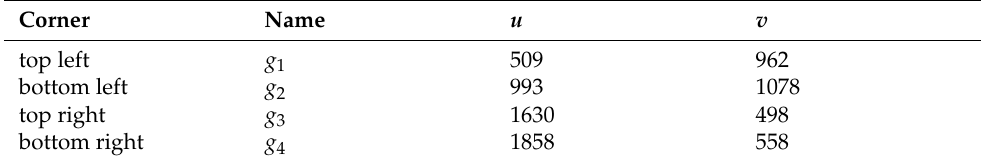
Table 6. Domain ˆ Q im corners coordinates in ˆ Φ , Example 2.